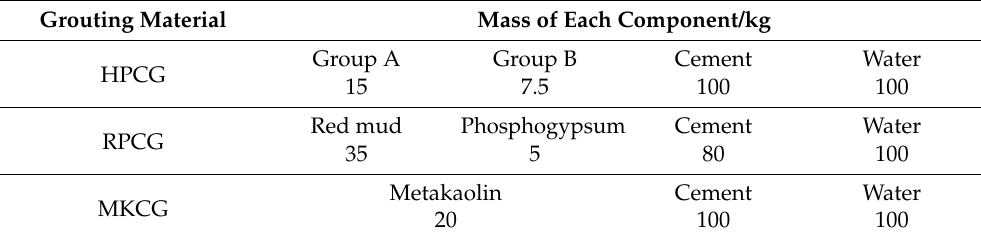
Table 5. Proportion of test